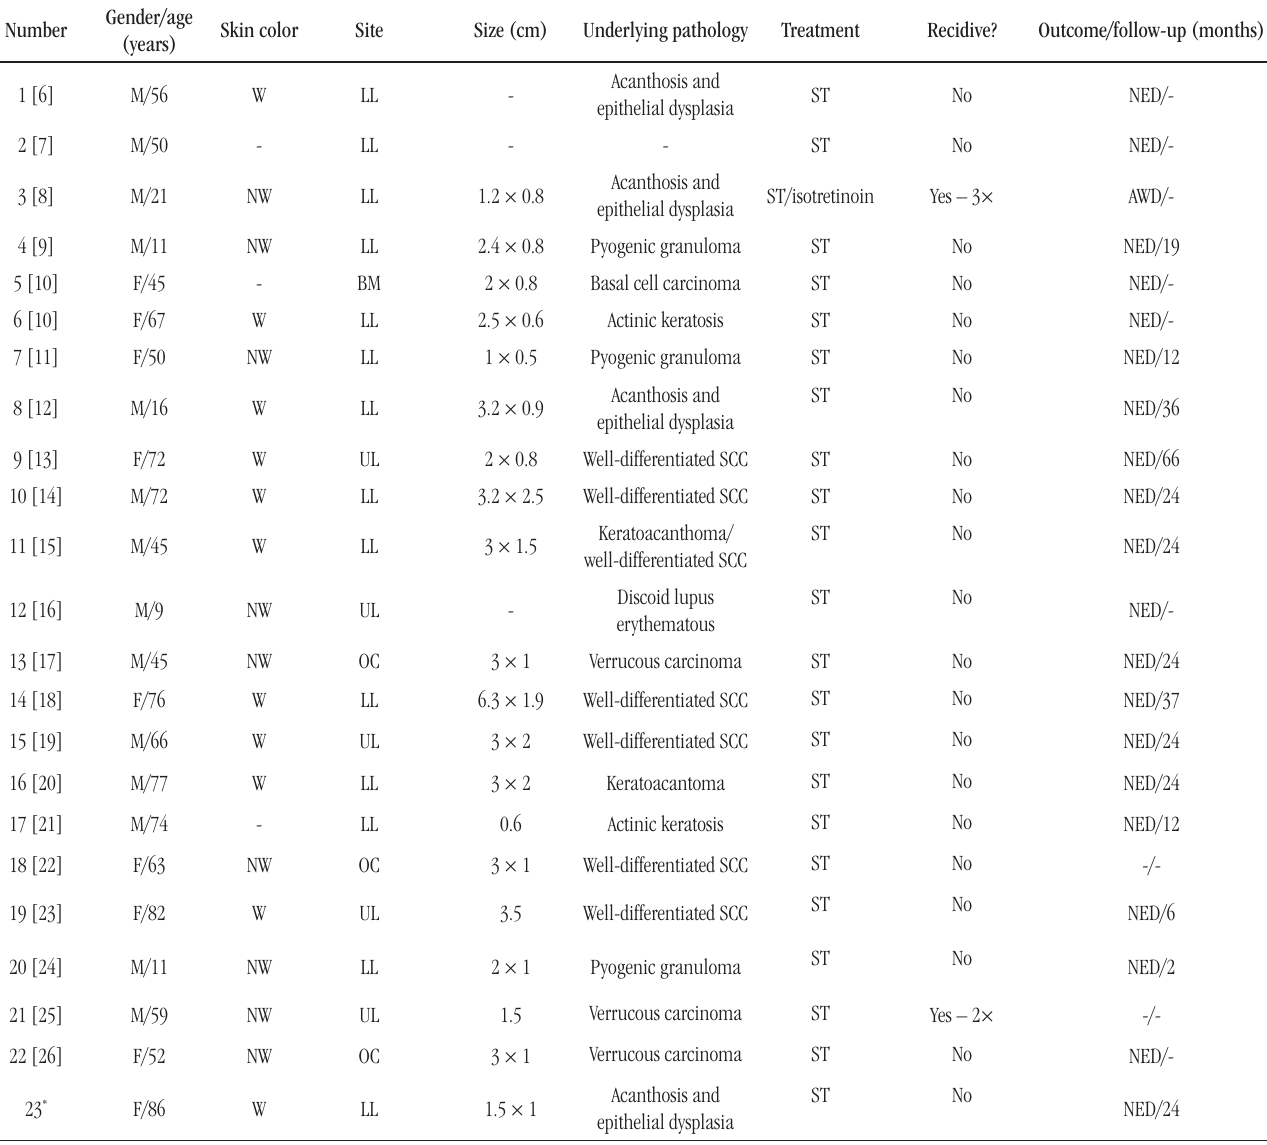
TABLE 1 – Clinical pathological data of retrieved cases from international